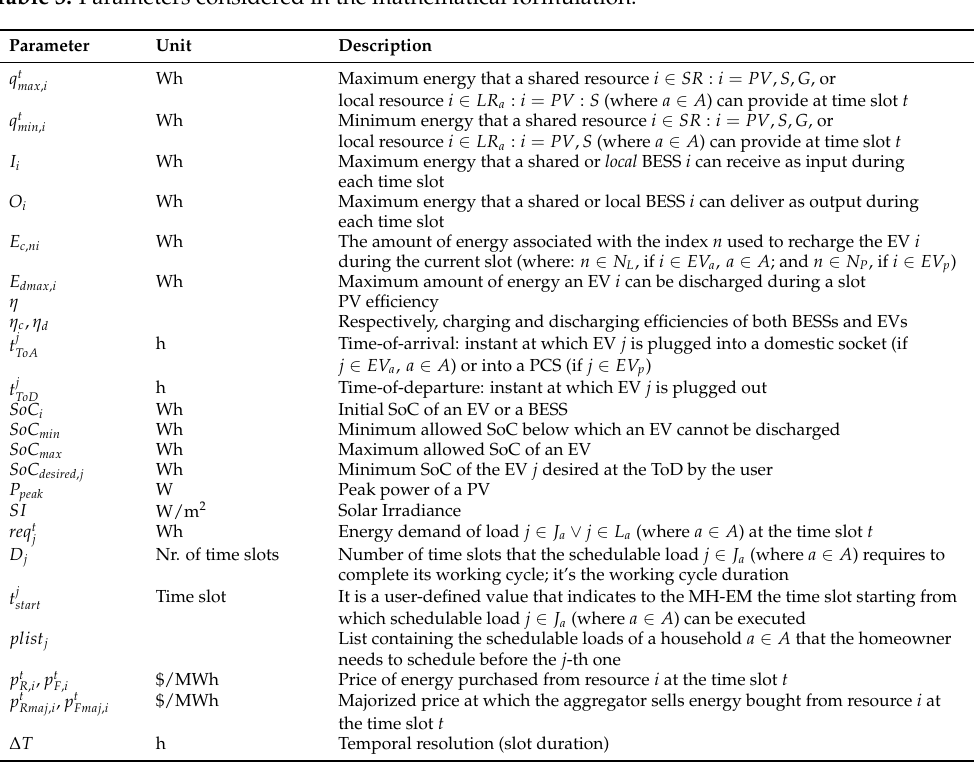
Table 3. Parameters considered in the mathematical formulation.